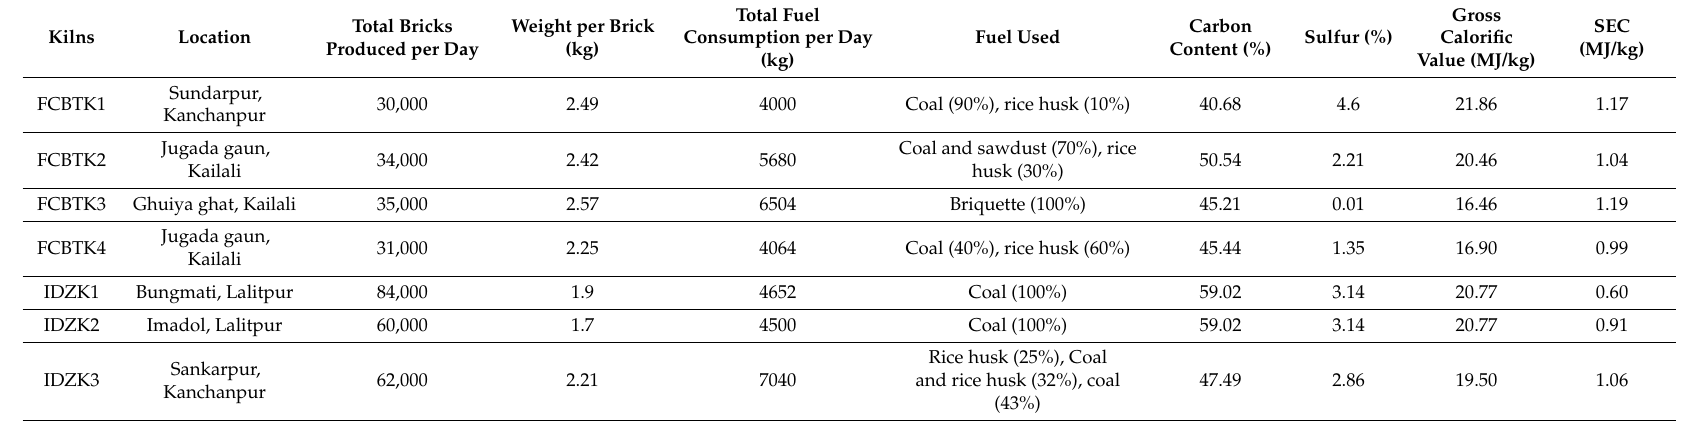
Table 1. Details about the kilns measured (including location, capacity, fuel used) and results of fuel analysis and specific energy consumption. Kilns